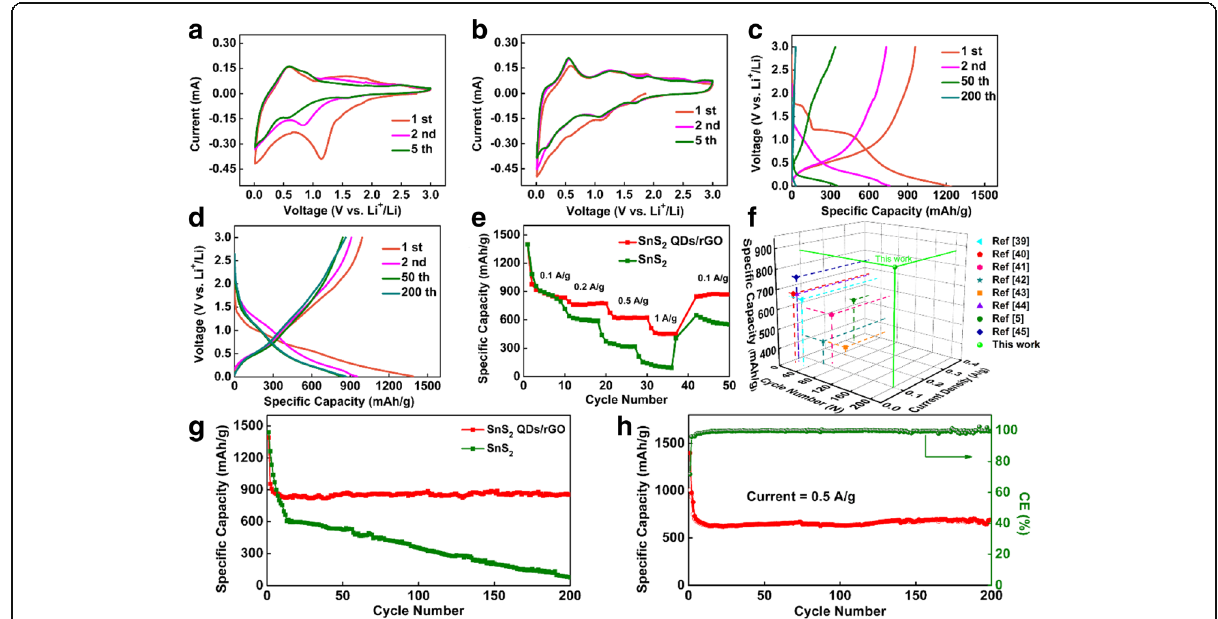
Fig. 3 Electrochemical performance of the pure SnS 2 and 3D SnS 2 QDs/rGO composite electrodes for LIBs: a , b CV curves of the pure SnS 2 and 3D SnS 2 QDs/rGO composite electrodes at a scan rate of 0.1 mV/s for the first five cycles. c Charge/discharge curves of the pure SnS 2 composite electrode and d the 3D SnS 2 QDs/rGO composite electrode at a current density of 0.1 A/g in the voltage range of 0.01 – 3.0 V vs. Li + /Li. e Rate performance of the 3D SnS 2 QDs/rGO and pure SnS 2 composite electrodes at rates ranging from 0.1 to 1 A/g. f Comparison of electrochemical performance between the 3D SnS 2 QDs/rGO composite (the current study) and previously reported SnS 2 -based material composite. g Cycling performances of 3D SnS 2 QDs/rGO and pure SnS 2 composite electrodes at a current density of 0.1 A/g. h Cycling performance and Coulombic efficiency of 3D SnS 2 QDs/rGO composite electrode at a current density of 0.5